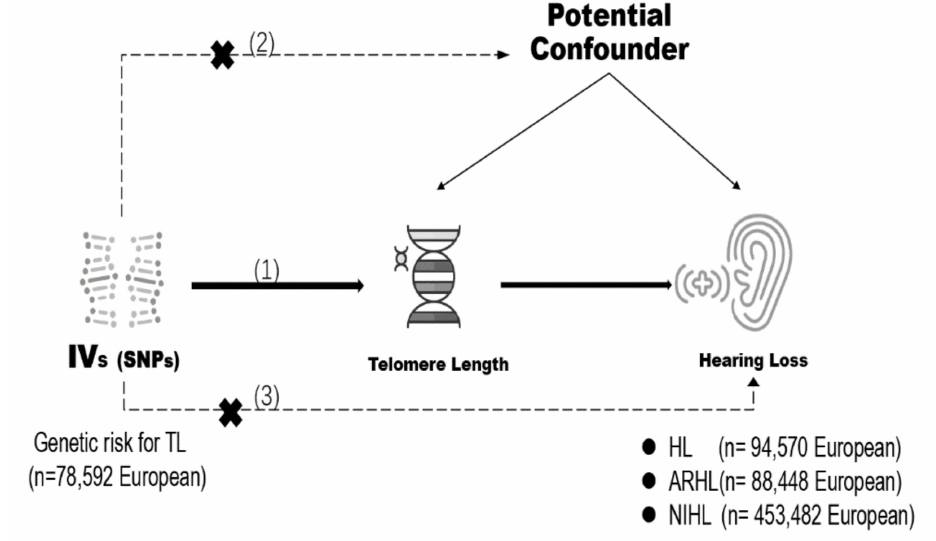
Figure 1. Schematic diagram of the two-sample Mendelian randomization analysis regarding the association of genetically predicted telomere length with risk of hearing loss and its